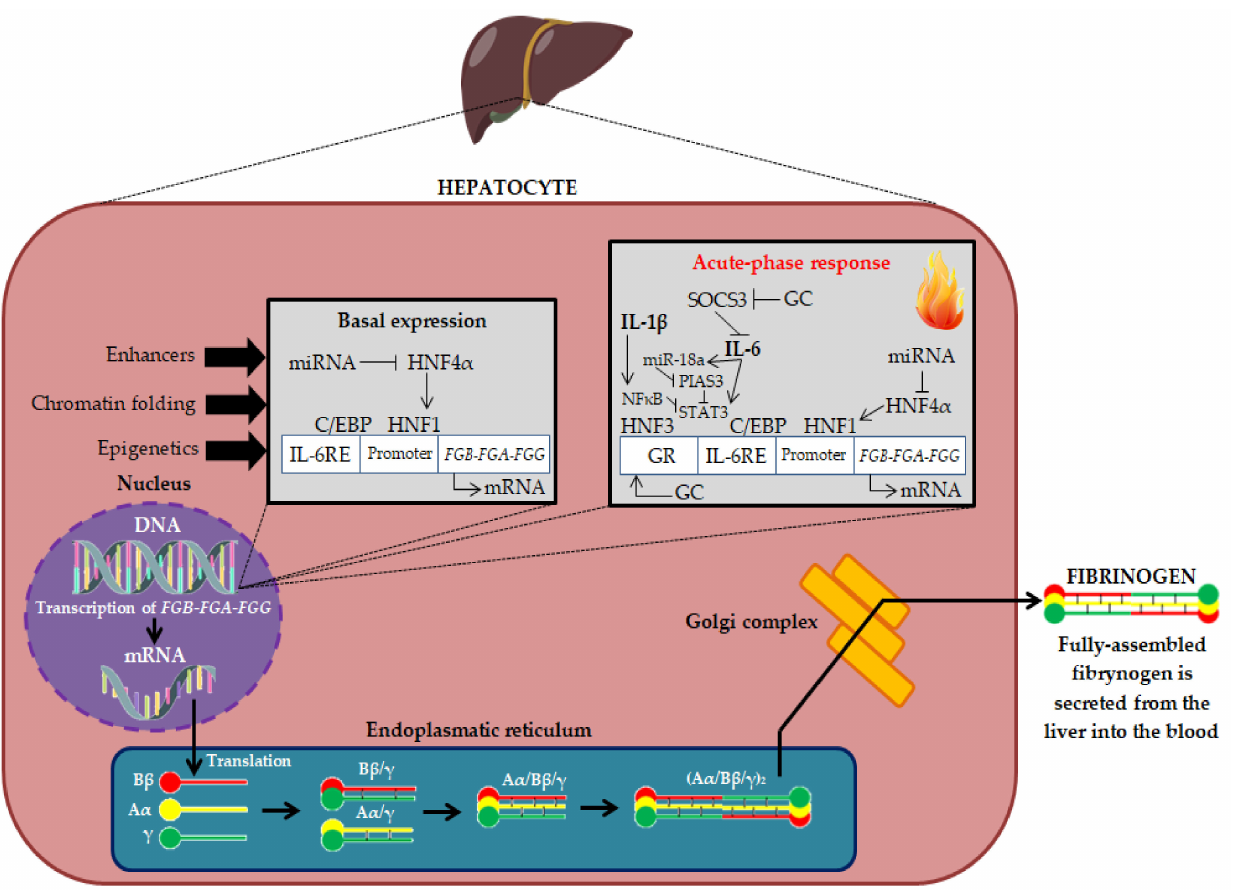
Figure 1. Fibrinogen biosynthesis in liver hepatocytes [9–11]. DNA—deoxyribonucleic acid; mRNA— Messenger ribonucleic acid; FGA-FGB-FGG—Fibrinogen chain genes; miRNA—Micro RNA; HNF4 α